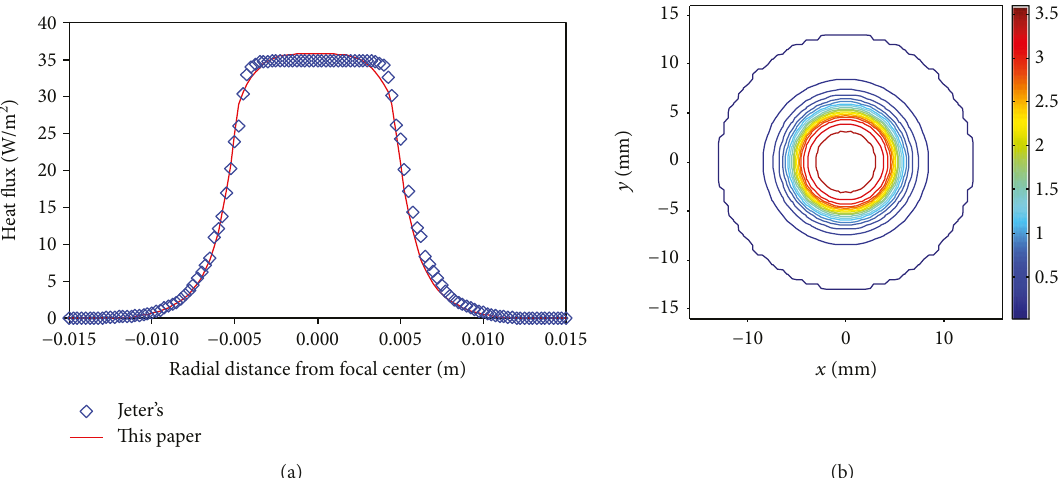
Figure 4: (a) The comparison of the fl ux distribution result on the focal plane and (b) fl ux distribution contour map using ray tracing method in this paper (W/m 2